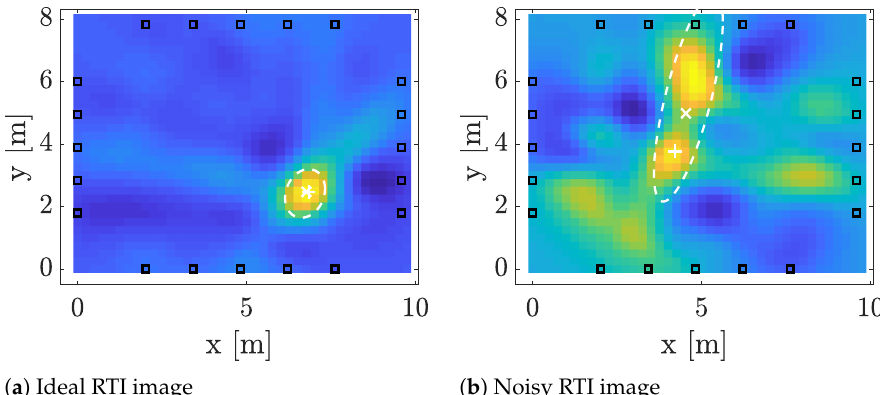
Figure 4. Two example RTI images and the position and covariance estimates calculated using (12) and (13). In the image, the deep blue regions indicate areas that are not occupied by people and the bright regions indicate estimated obstructions. Furthermore, the plus sign indicates the true position, the crosses are the position estimates, and the dashed line illustrates the 3 σ uncertainty ellipse [3], reprinted with permission from ref. [3]. Copyright 2019